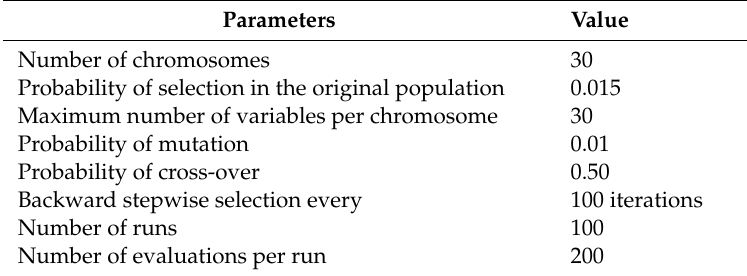
Table A3. Regression coefficients extracted from the PLS model based on the 29 descriptors selected by GA.